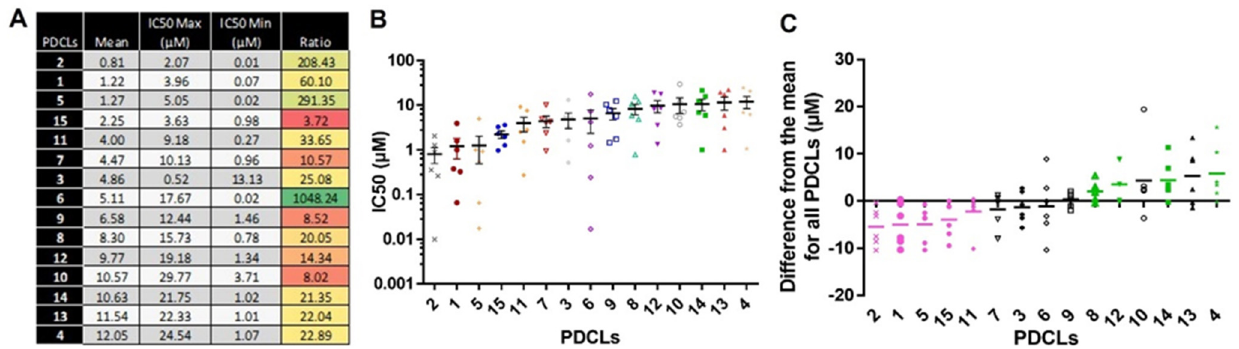
Figure 3. The range of response to ferrocifens differs between PDCLs. ( A ) For each PDCL, the mean IC 50 obtained for all compounds, the highest (IC 50 max) and lowest (IC 50 min) and their ratio. Shades of green indicate the largest ratios, shades of red indicate the smallest ratios. ( B ) For each PDCL, the graphical representation of mean IC 50 values for all compounds and the range is shown. ( C ) For each PDCL, the graphical representation of the difference from the mean IC 50 value obtained for all compounds (as listed in Figure 2B) and individual values obtained for each compound are shown. PDCLs with negative values are classified as sensitive and PDCLs with positive values are classified as resistant to the ferrocifen complexes.